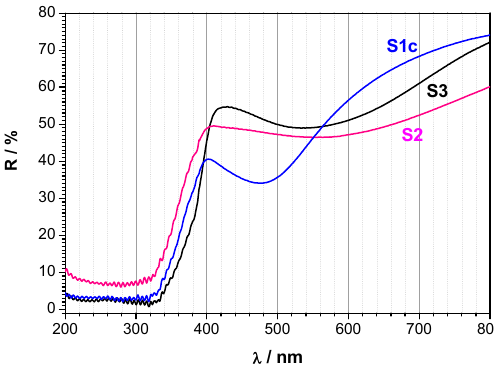
Figure 5. UV–Vis di ff use-reflectance spectra of prepared Ag@TiO2 photocatalysts S1c, S2, and S3. Table 1. Band gaps of investigated samples calculated from UV ‐ Vis measurements using formula [F(R) × h υ ] 1/2 [26].